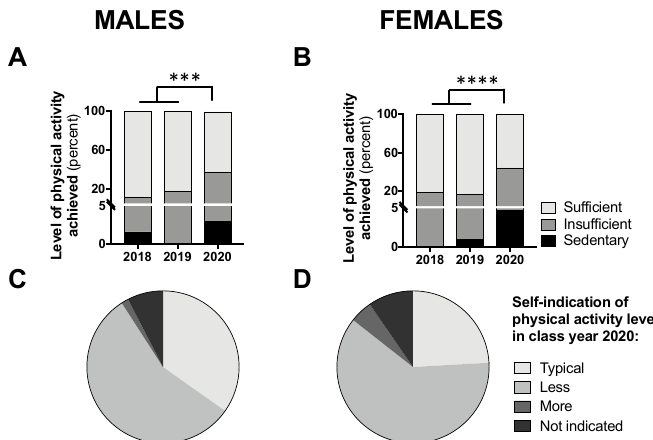
Figure 5. Students achieving “sufficient” physical activity levels in class year 2020 ( n = 66 males, 83 females) compared with 2018 ( n = 61 males, 97 females) and 2019 ( n = 73 males, 104 females) ( A , B ) and students self-indicating “typical” levels of physical activity in year 2020 ( C , D ). Data are presented as the proportion of students included in this analysis each year. For ( A , B ), no statistical differences were observed between 2018 and 2019 and, therefore, to meet the assumptions of the chi-square test, these years were combined and compared with 2020; *** p < 0.001 and **** p < 0.0001 between 2020 and 2018/2019 for “sufficient” vs. “sedentary/insufficient” by chi-square test.